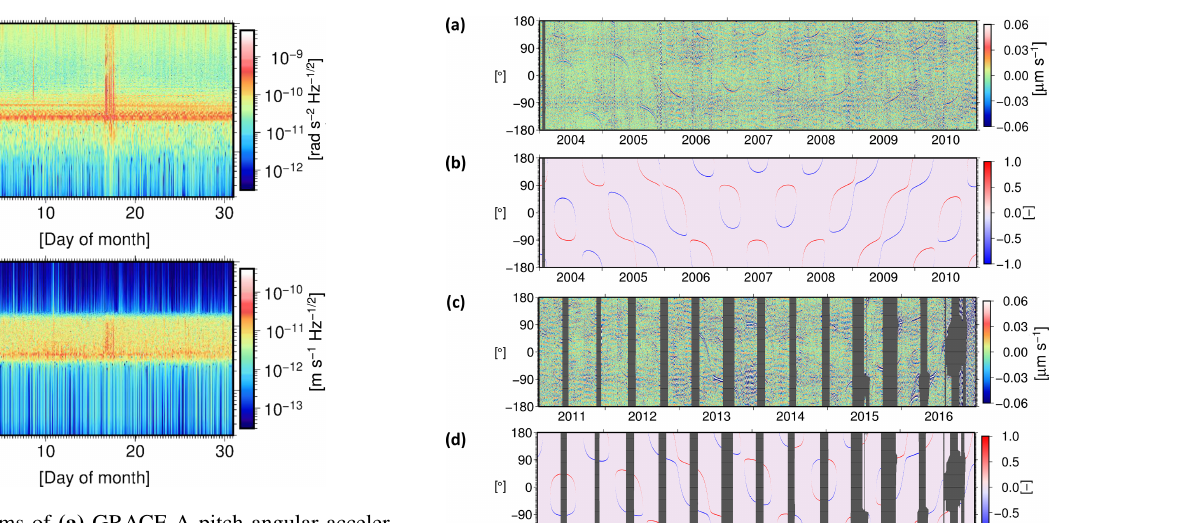
Figure 10. Spectrograms of (a) GRACE-A pitch angular acceler- ation variation and (b) medium timescale details of the residuals. The signal at 3.3mHz, which according to Bandikova et al. (2012) is induced by magnetic torque attitude control, is clearly visible in the residuals for December 2008.